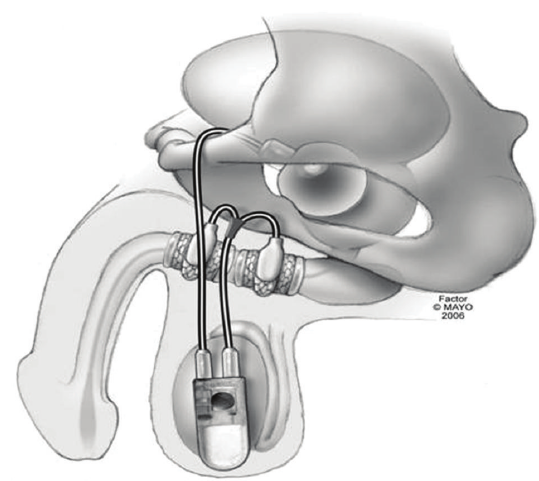
Figure 6: Graphical representation of the tandem-cu ff artificial urinary